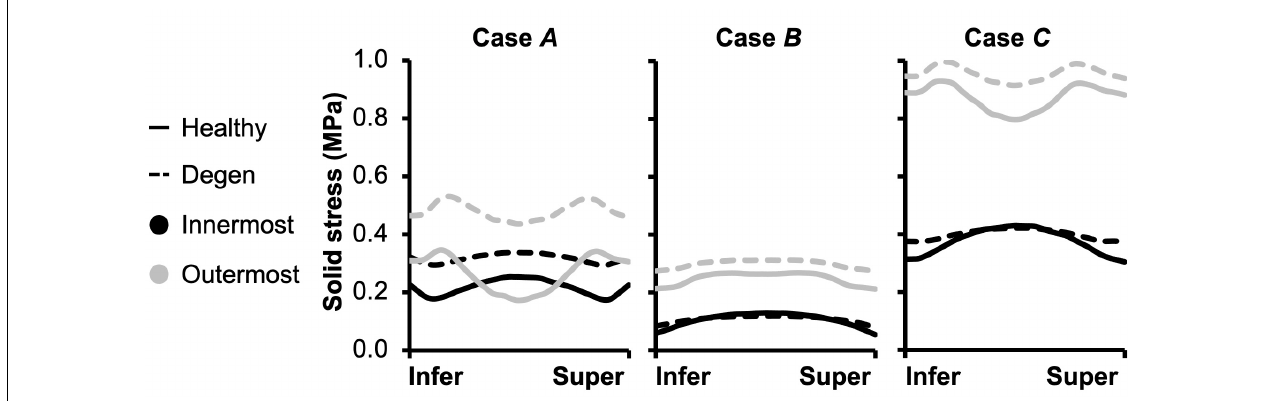
FIGURE 11 | Model-predicted post-loading annulus fibrosus (AF) fiber solid stress profiles along the fiber length from the inferior (Infer) to the superior (Super) bony endplates. The stress distributions were evaluated for the inner- and outermost AF layers in both healthy and degenerated (Degen)